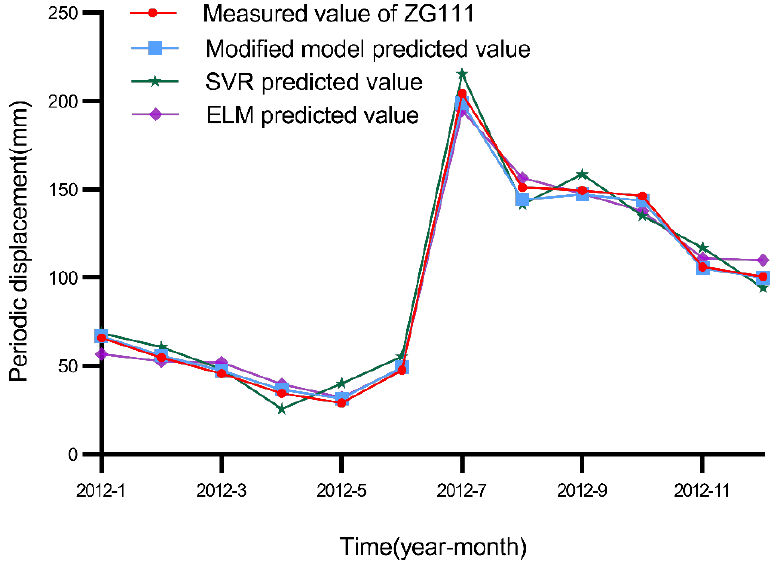
Figure 24. Periodic displacement predicted results of ZG111 using LSTM-FC, SVR and ELM models.